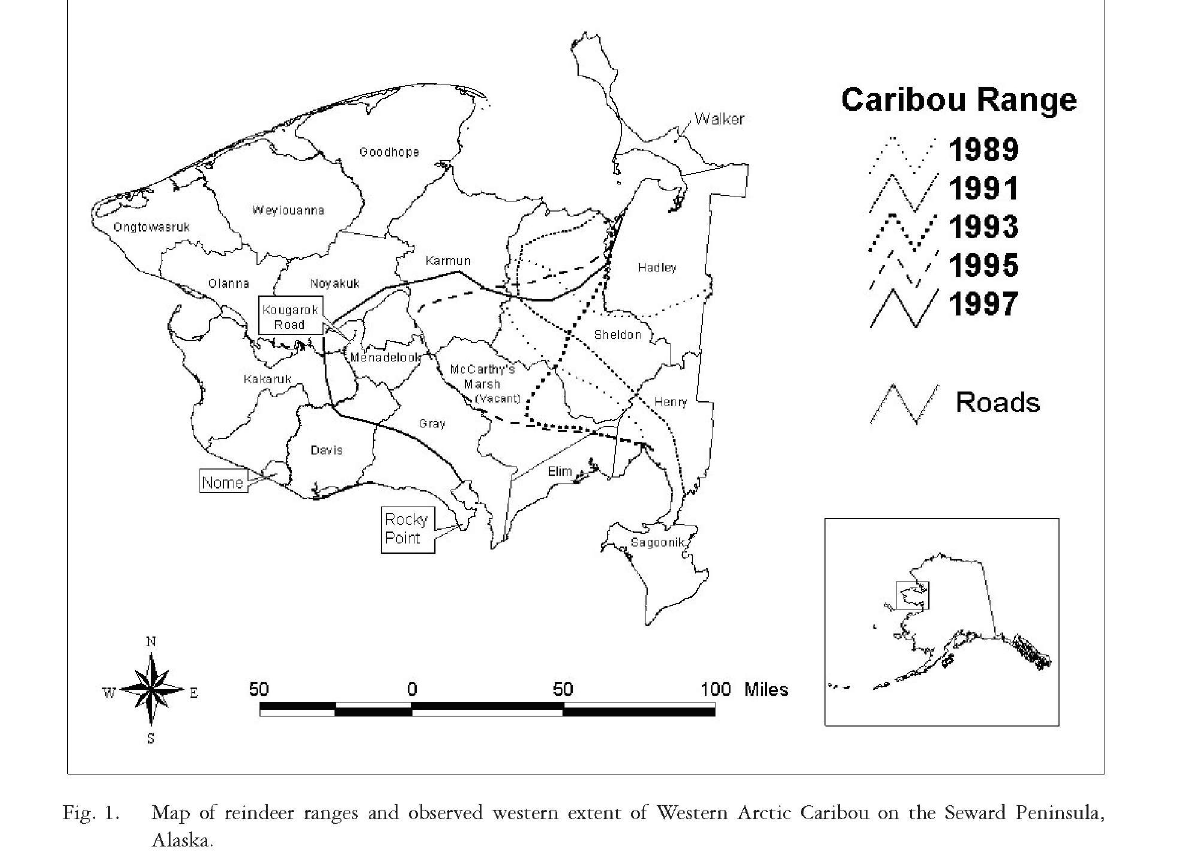
Map of reindeer ranges and observed western extent of Western Arctic Caribou on the Seward Peninsula,